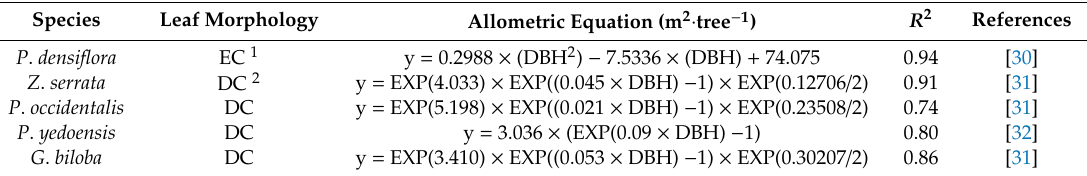
Table 2. Allometric equations to calculate TLA values using DBH for tree species.